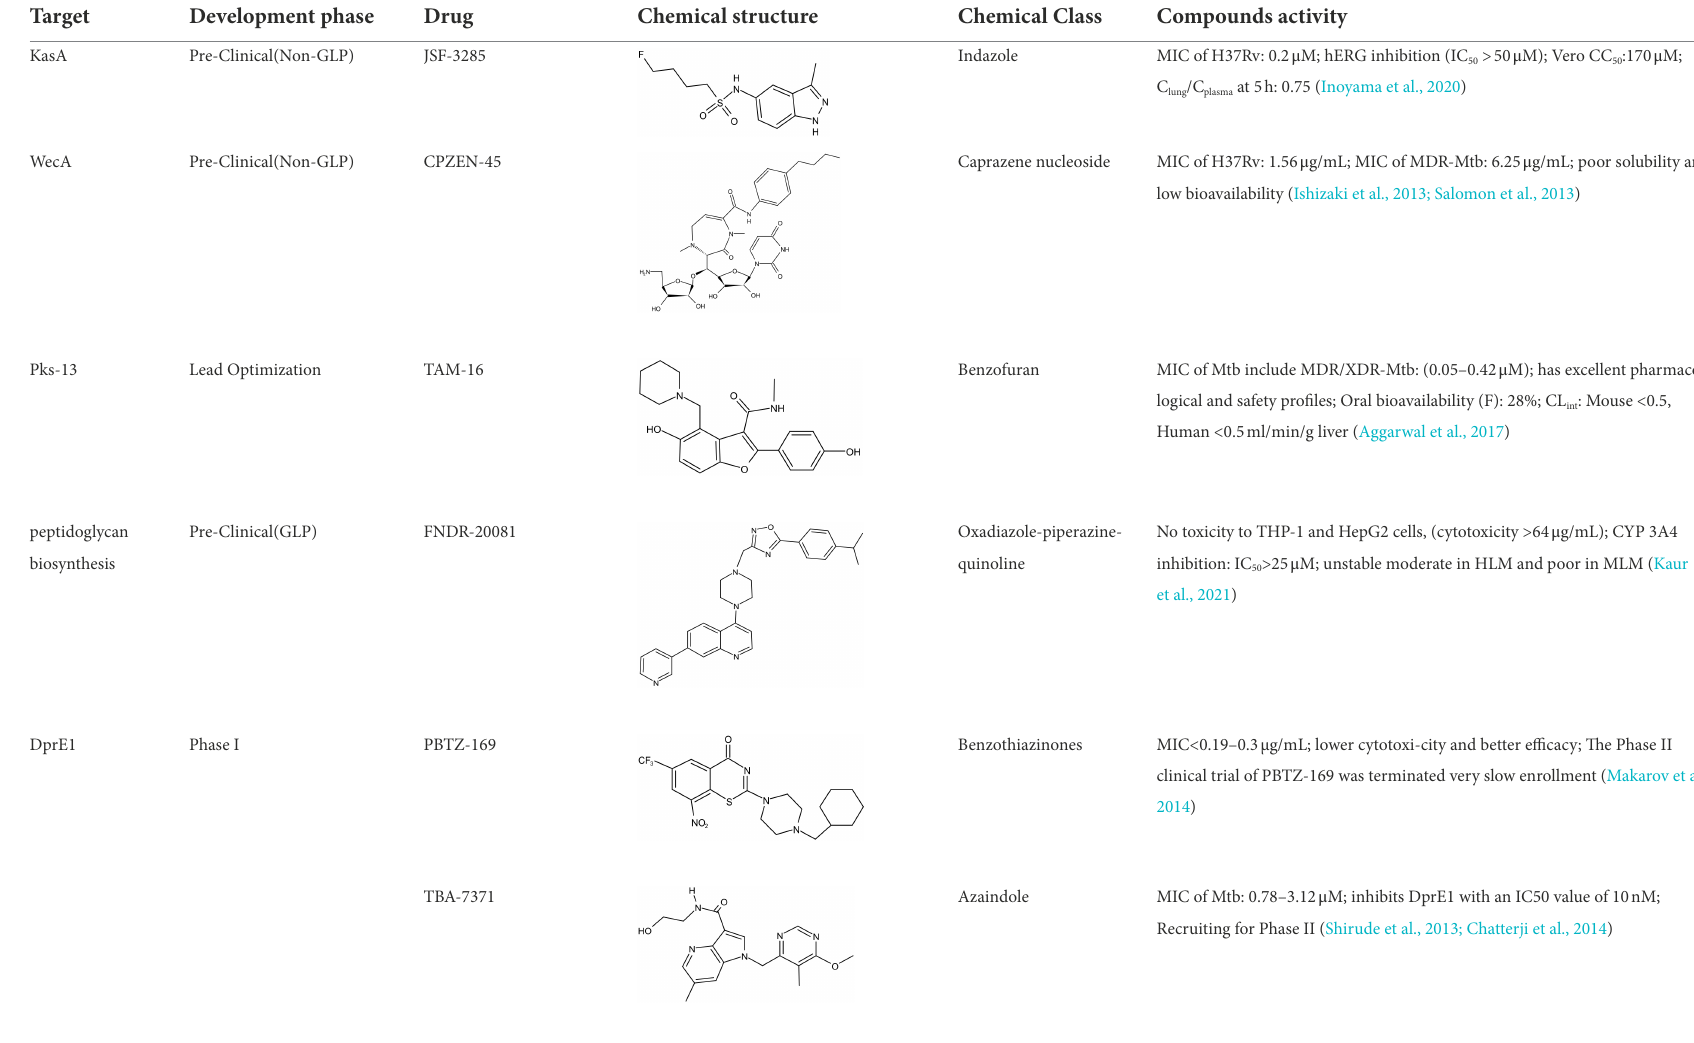
TABLE 1 Molecules in various stages of drug discovery, their targets, chemical structure, efficacy against Mycobacterium tuberculosis and some other